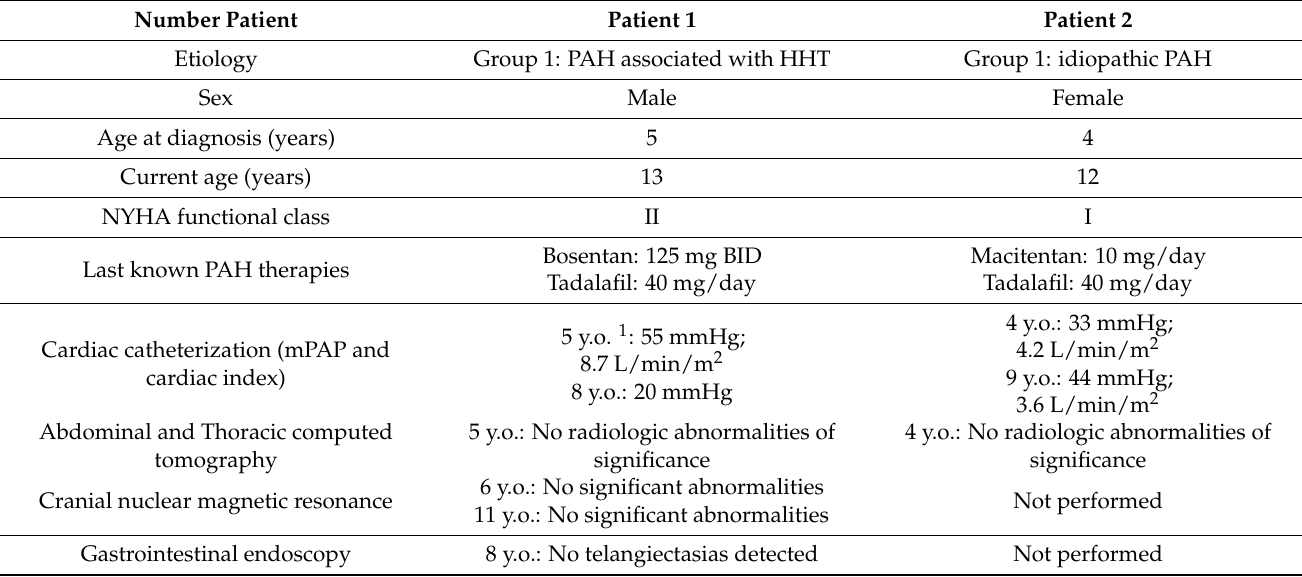
Table 1. Clinical information. Main clinical characteristics of the patients and results obtained in the tests performed from diagnosis to the present